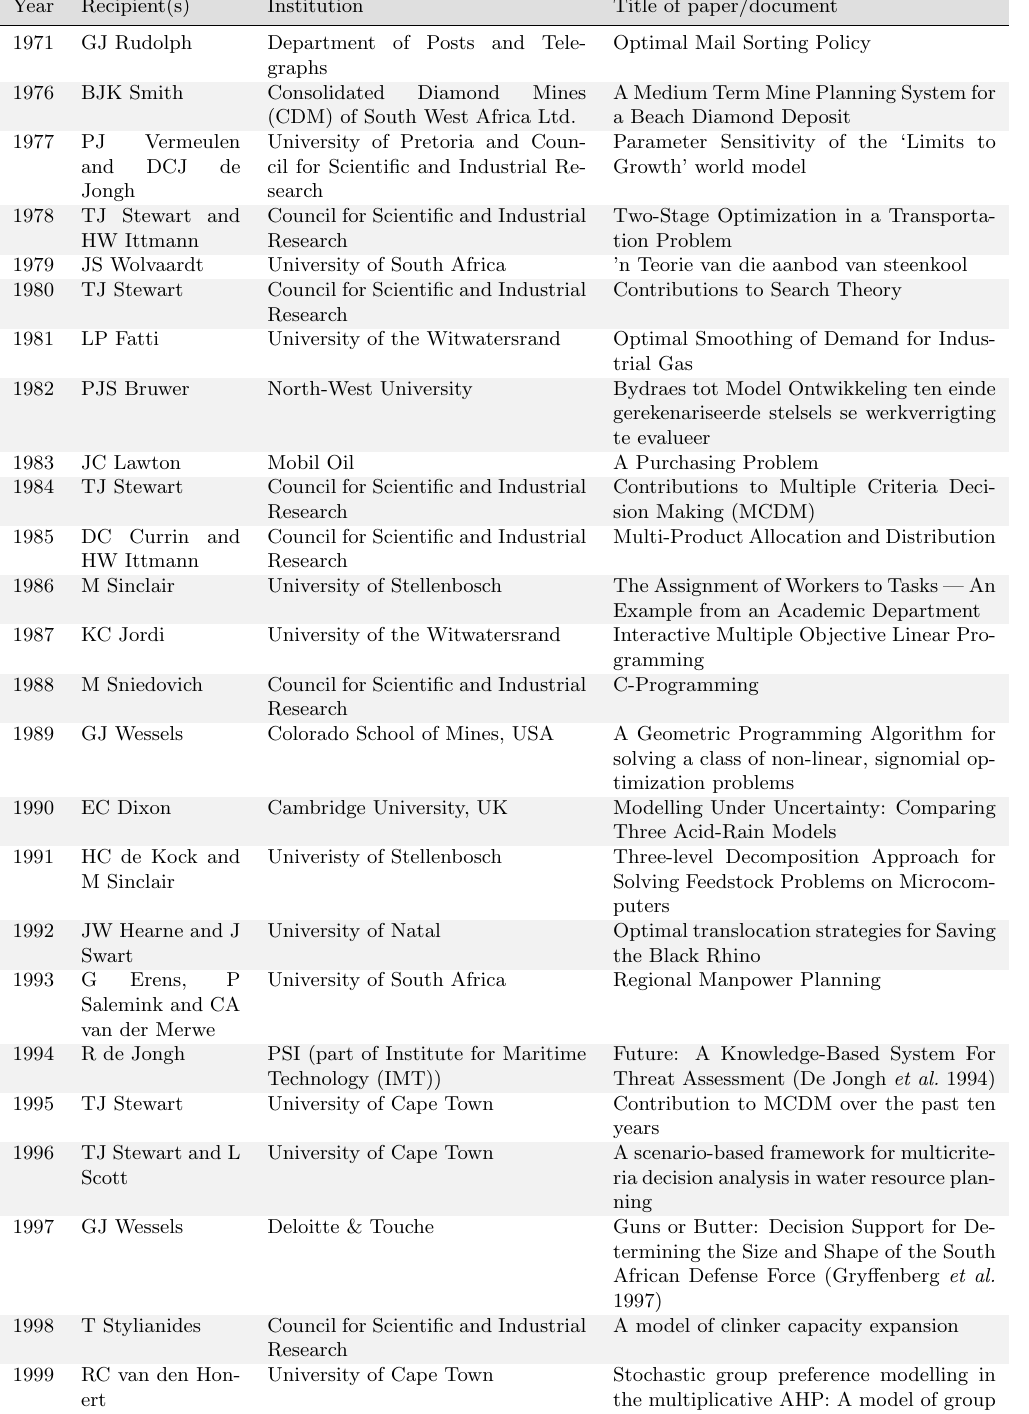
Table 1: A list of TR medal recipients from